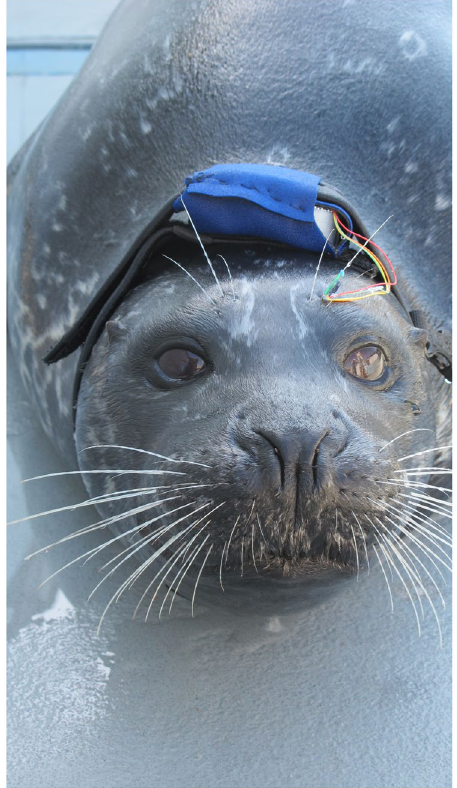
Figure 1. The accelerometer tag worn by a trained harbor seal. Photograph of the seal wearing the tag during live animal testing. The digital accelerometer is attached to a supraorbital whisker and connected by small wires to the datalogger, which is fitted to the animal’s head inside a pocket of the neoprene